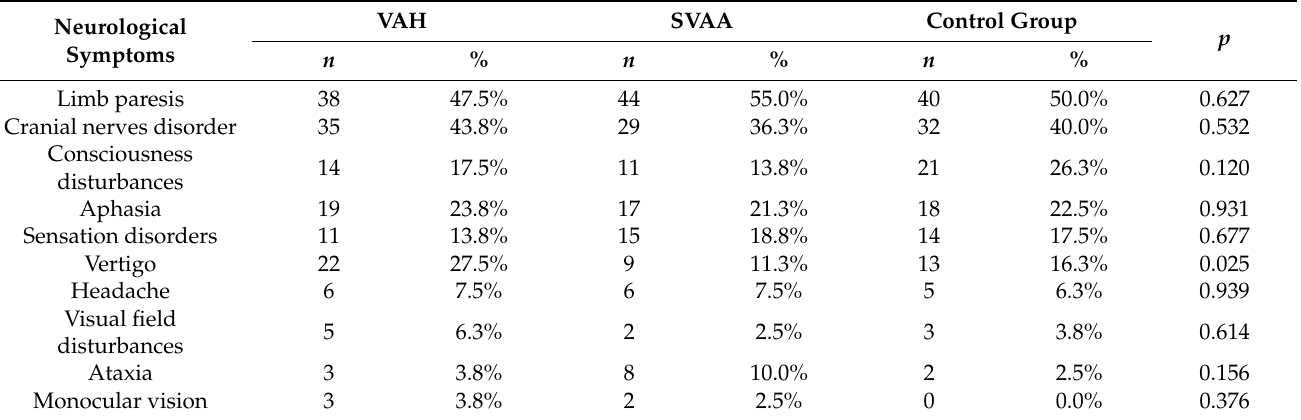
Table 3. Frequency of neurological